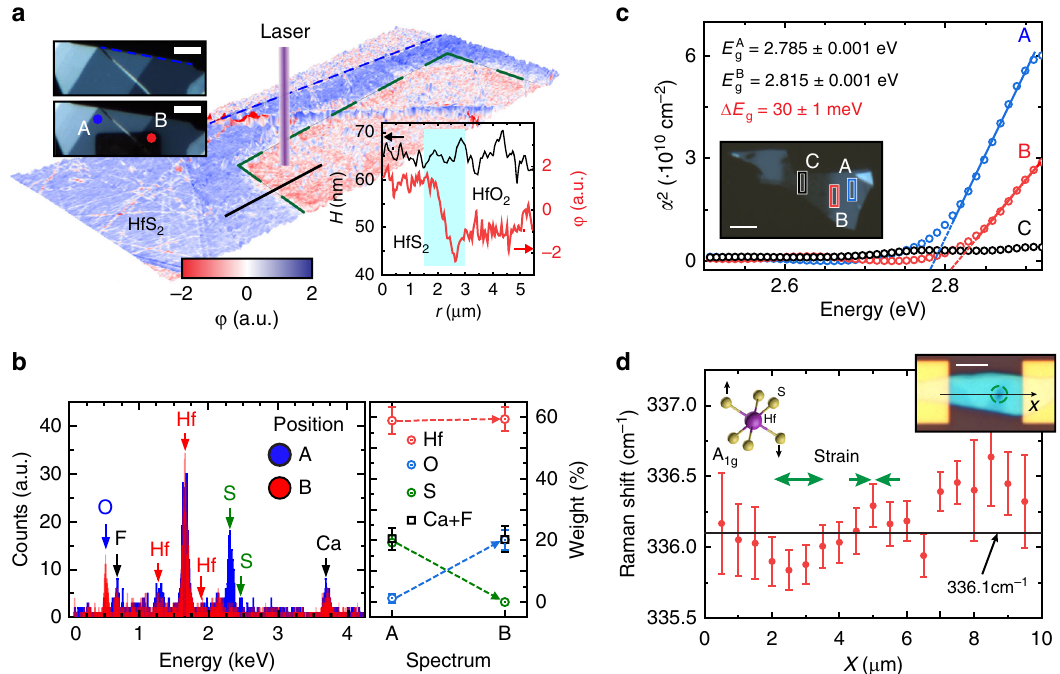
Fig. 2 Photo-oxidation and strain engineering in HfS 2 . a AFM topography with phase contrast φ signal superimposed of a representative fl ake after laser exposure (green-dashed line). Top-left inset: optical micrograph of the fl ake before (top) and after (bottom) laser-assisted oxidation. Bottom-right inset: height (H) and phase signal along a 5 μ m line-cut (black line). Scale bars are 5 μ m. b EDXMA spectra acquired in the regions A and B in panel a and quantitative analysis of the chemical elements (right). c Square of the absorption coef fi cient ( α 2 ) of: (A) HfS 2 away and (B) close to the oxidised area and = 2.785± 0.001 eV and E B = 2.815 ± 0.001 eV, Δ E = 30 ± 1 meV. Inset: optical micrograph of the fl ake where (C) HfO 2 . Extrapolated direct bandgap: E A g g g the colour boxes represent the sampling areas (1 × 3 μ m) in which the absorption spectra where acquired. Spectrum (B) is centred at 1 μ m from the edge of the oxide area. Scale bar is 4 μ m. d Frequency of the A 1g mode of HfS 2 as a function of position along the photo-engineered device shown in the inset (green circle indicates the photo-oxidised area). The horizontal solid line marks the average frequency of an as-fabricated fl ake at 336.1 cm − 1 , tensile (compressive) strain is marked by a down- (up-) shift of this mode (green arrows). Error bars represent the uncertainty of the Lorentzian fi t of the